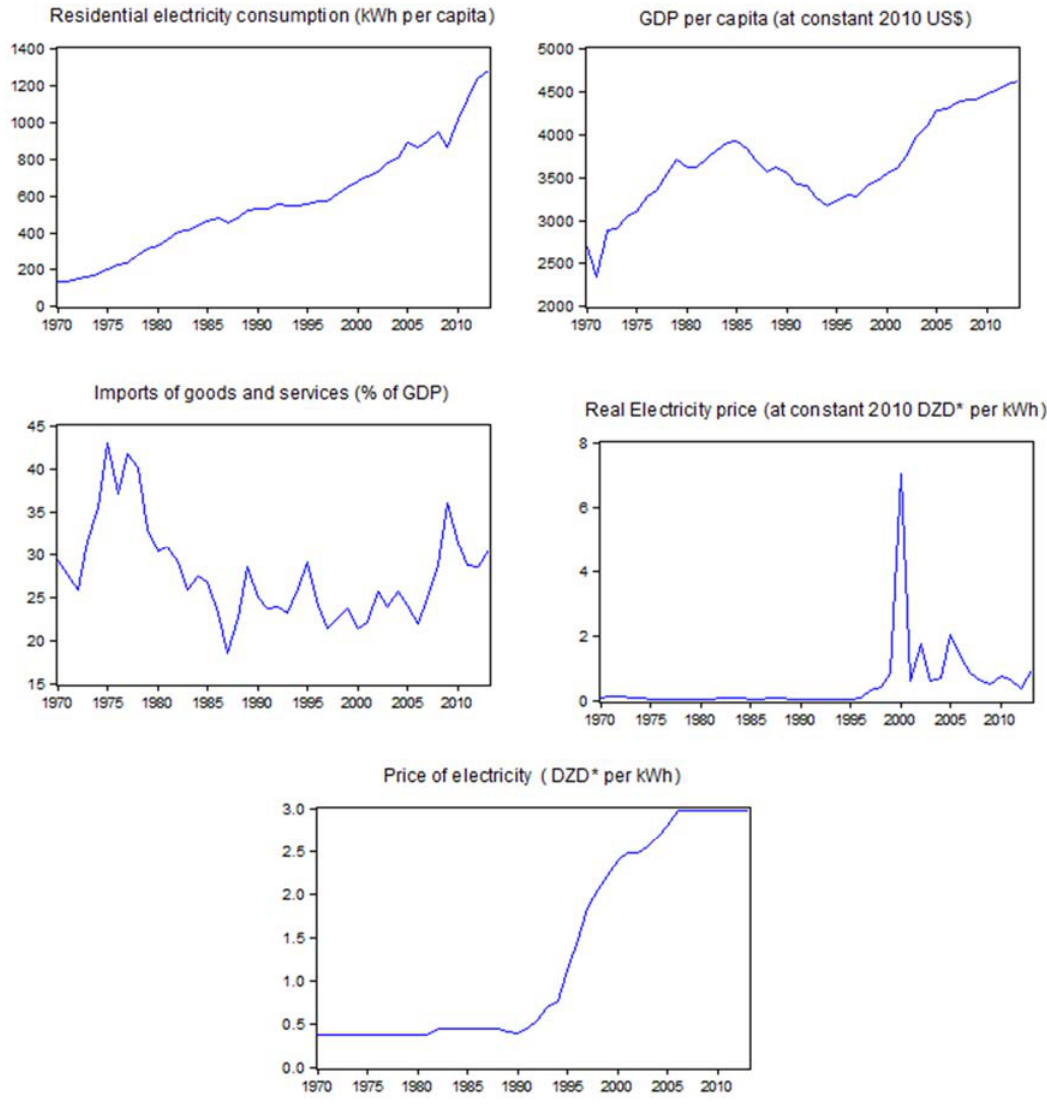
Figure 1. Graphs of studied variables. DZD *: The Algerian Dinar (national currency of Algeria).